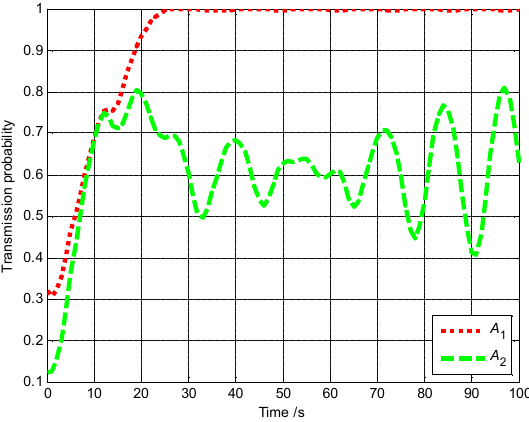
Figure 25. The probabilities of successful transmission of A 1 and A 2 to base station (Group B in Scenario 2).